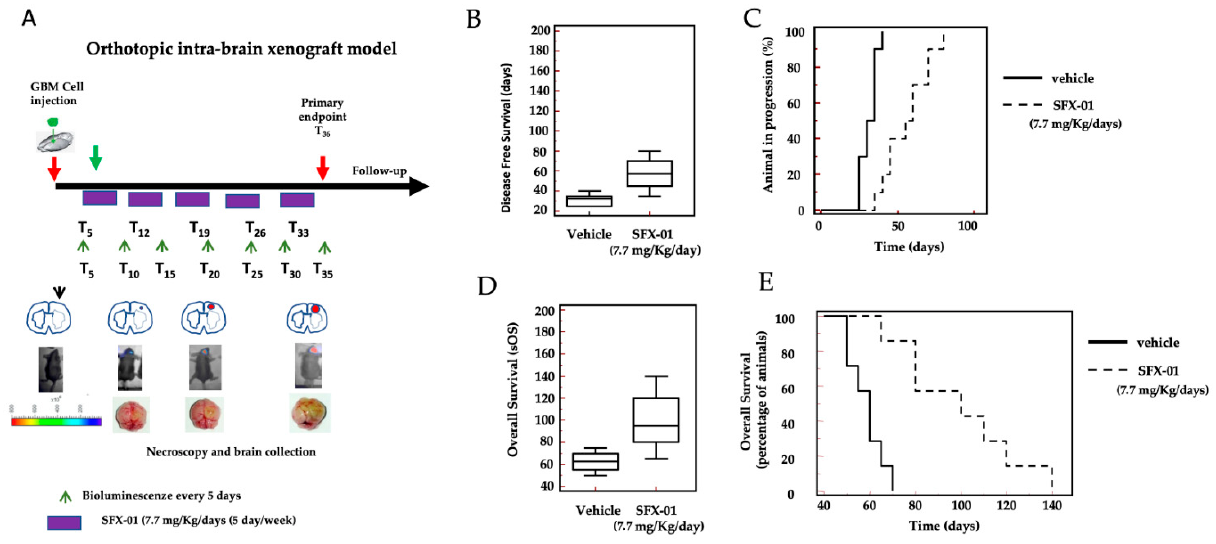
Figure 8. SFX-01 inhibited tumor growth in an orthotopic model for GBM in mice. U87MG cells expressing luciferase were orthotopically implanted into athymic nude mice, and tumor growth was monitored using a UVITEC Cambridge Mini HD6 (UVItec Limited, Cambridge, UK) imaging system for the detection of bioluminescence. Bioluminescent signals were measured every week, in order to record the time of bioluminescence signal appearance (equivalent of disease-free survival, DFS): ( A ) treatment scheme; ( B ) disease-free survival (days) graph; ( C ) representative Kaplan-Meyer analysis for DFS; ( D ) surrogate overall survival (sOS, days) graph; and ( E ) Kaplan-Meier analysis for sOS. The data presented here indicate that SFX-01 increased both the DFS and sOS of animals bearing orthotopic intra-brain U87MG tumors. The dose equivalent of 7.7 mg/Kg contained in 50 mg/Kg SFX-01 is indicated in the panels of this